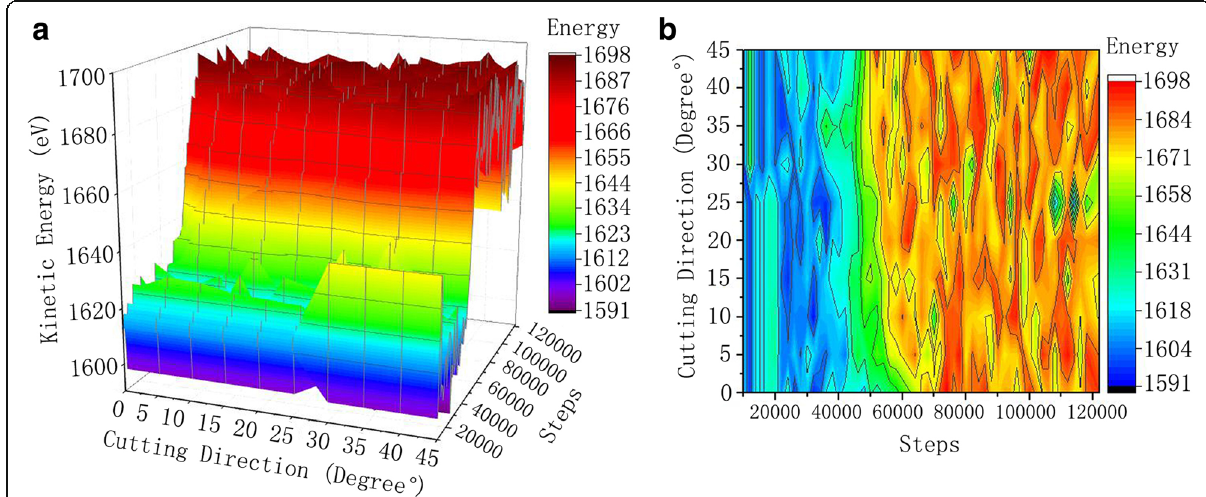
Fig. 7 Kinetic energy curve of the workpiece atoms. Figure 7 is the kinetic energy curve of the different cutting angles during the cutting process. With the increase in the number of simulation steps, the kinetic energy of the atoms fluctuates in a low range, and then to a higher range within the fluctuations. a 3D curve. b